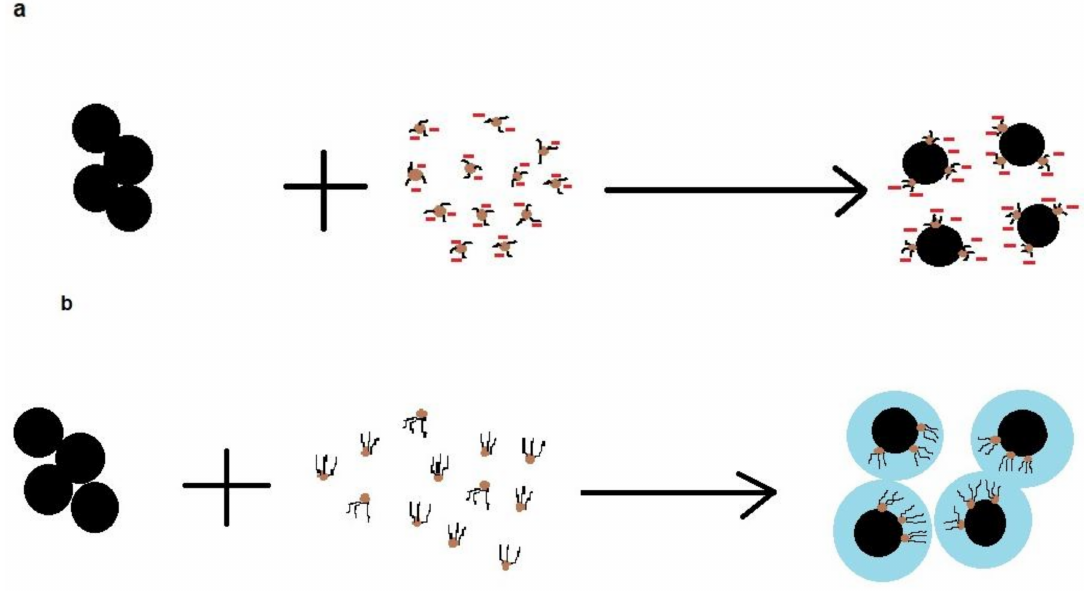
Figure 5. Mechanism of dispersants in stabilizing particles in suspensions ( a ) surface charge density effect and ( b ) hydrophilicity